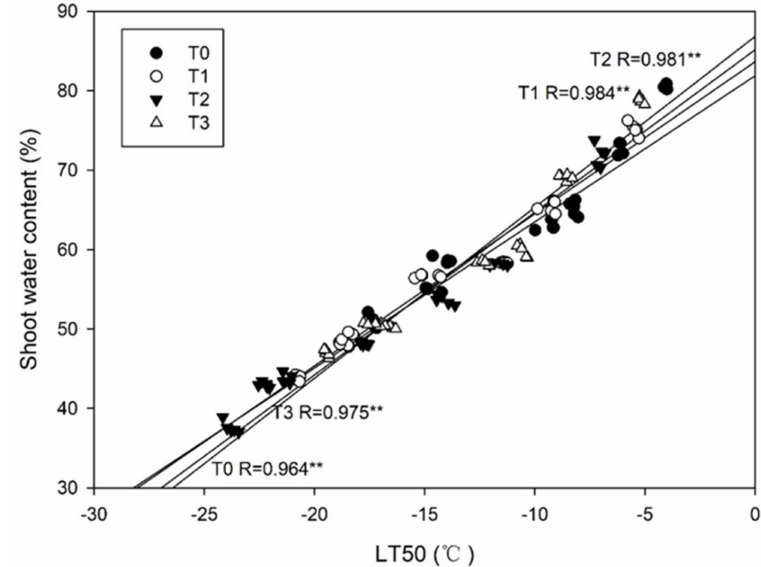
Figure 10. Correlation coe ffi cients between the freezing tolerance (estimated as LT50) and water content in the shoots of Magnolia wufengensis under ETH treatments. Note: T0, T1, T2, and T3 indicate the application of 0, 700, 1000, and 1500 mg · L − 1 ETH, respectively. The regression line is T2, T1, T3, and T0 from the top to bottom. ** indicate significance at p < 0.01, respectively.